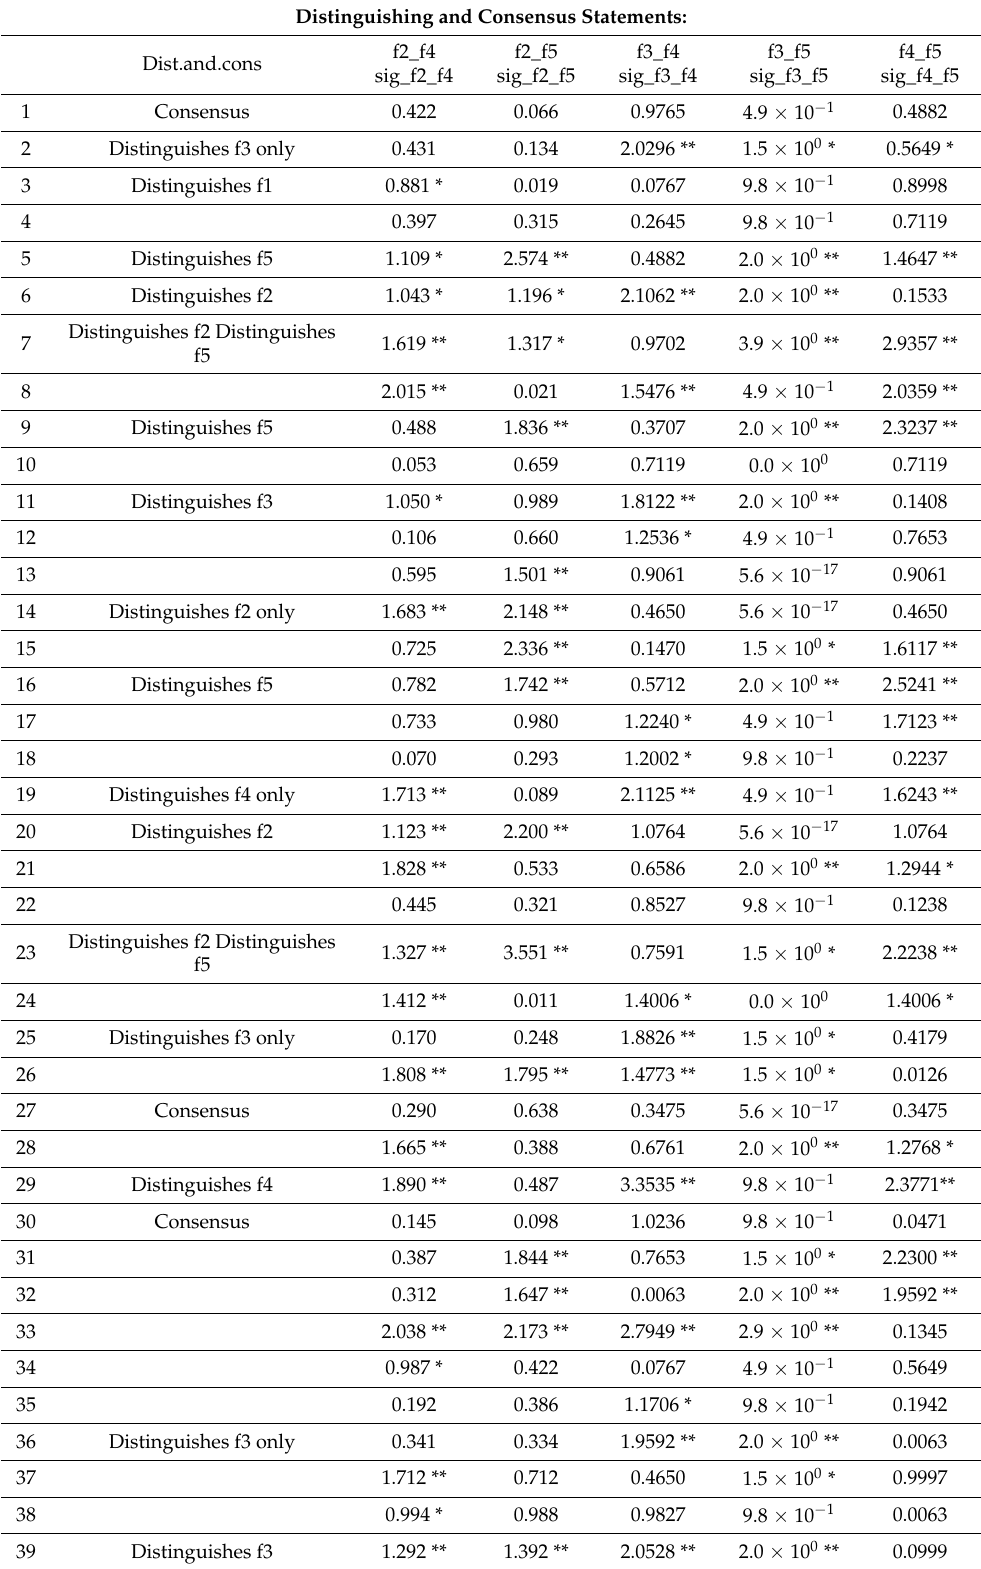
Table A4. Factor characteristics. Distinguishing and consensus